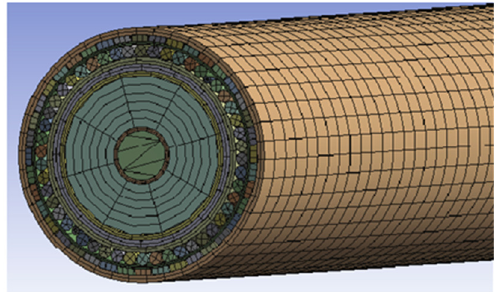
Figure 7. Finite element model of submarine cable [41].